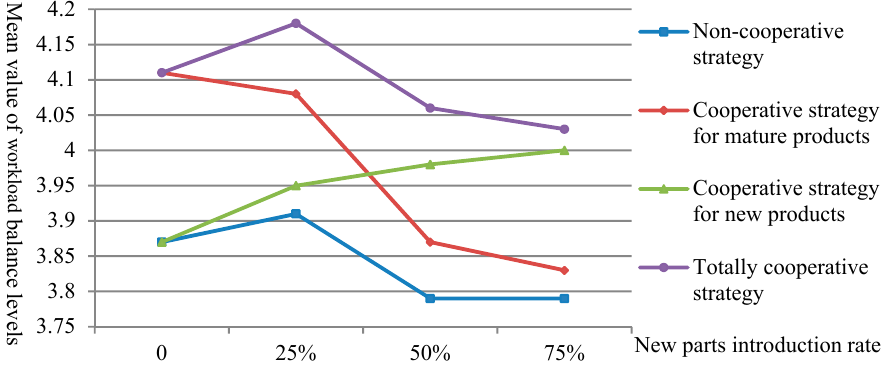
Figure 5. Mean values of workload balance levels under different conditions.